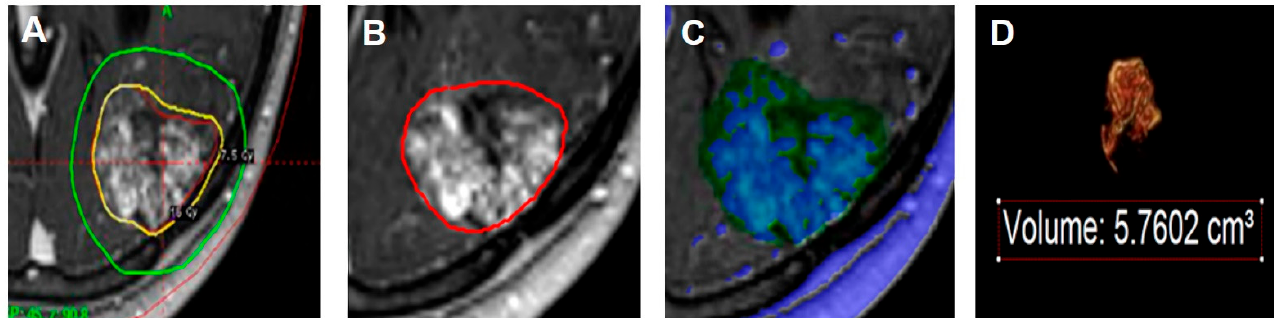
Figure 1. The process of the volumetric analysis. ( A ) The red line represents the target volume and the yellow line represents the 50% isodose line (IDL) in the Leksell GammaPlan. ( B ) The 50% IDL (red) is demarcated manually using Aquarius and defined as the measured volume within the 50% IDL. ( C ) The nidus volume within the 50% IDL (blue in green background) is calculated by adjusting the contrast threshold of the selected volume within the 50% IDL (green background). ( D ) The parenchyma volume within the 50% IDL is determined by subtraction of the nidus volume from the measured volume within the 50% IDL.